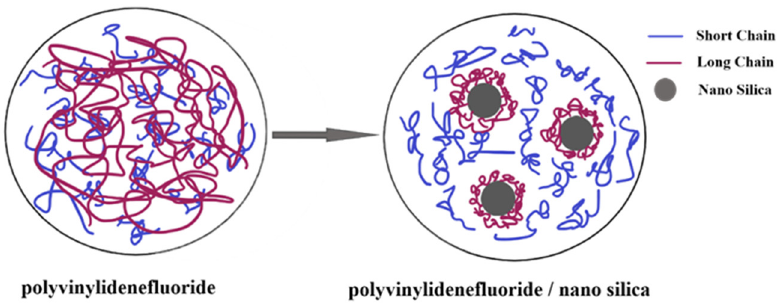
Figure 9. Schematic diagram of entanglement density of PVDF before and after dispersing SiO 2 na- SiO 2 noparticles.